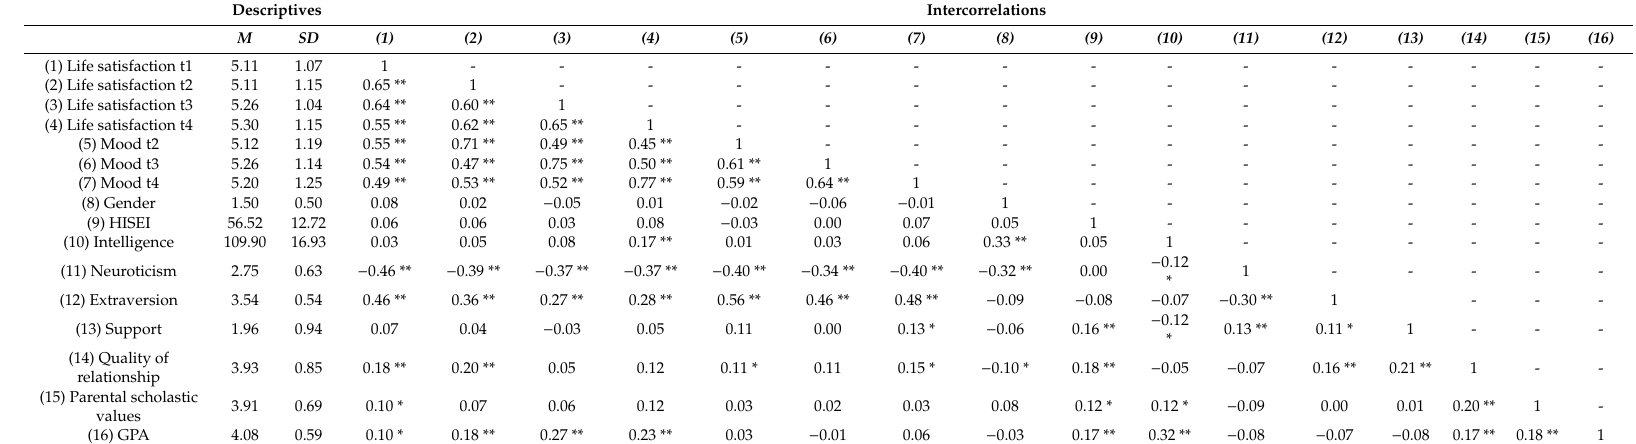
Table 2. Means ( M ), standard deviations ( SD ), internal consistencies ( α ), and intercorrelations among all predictors and criteria.